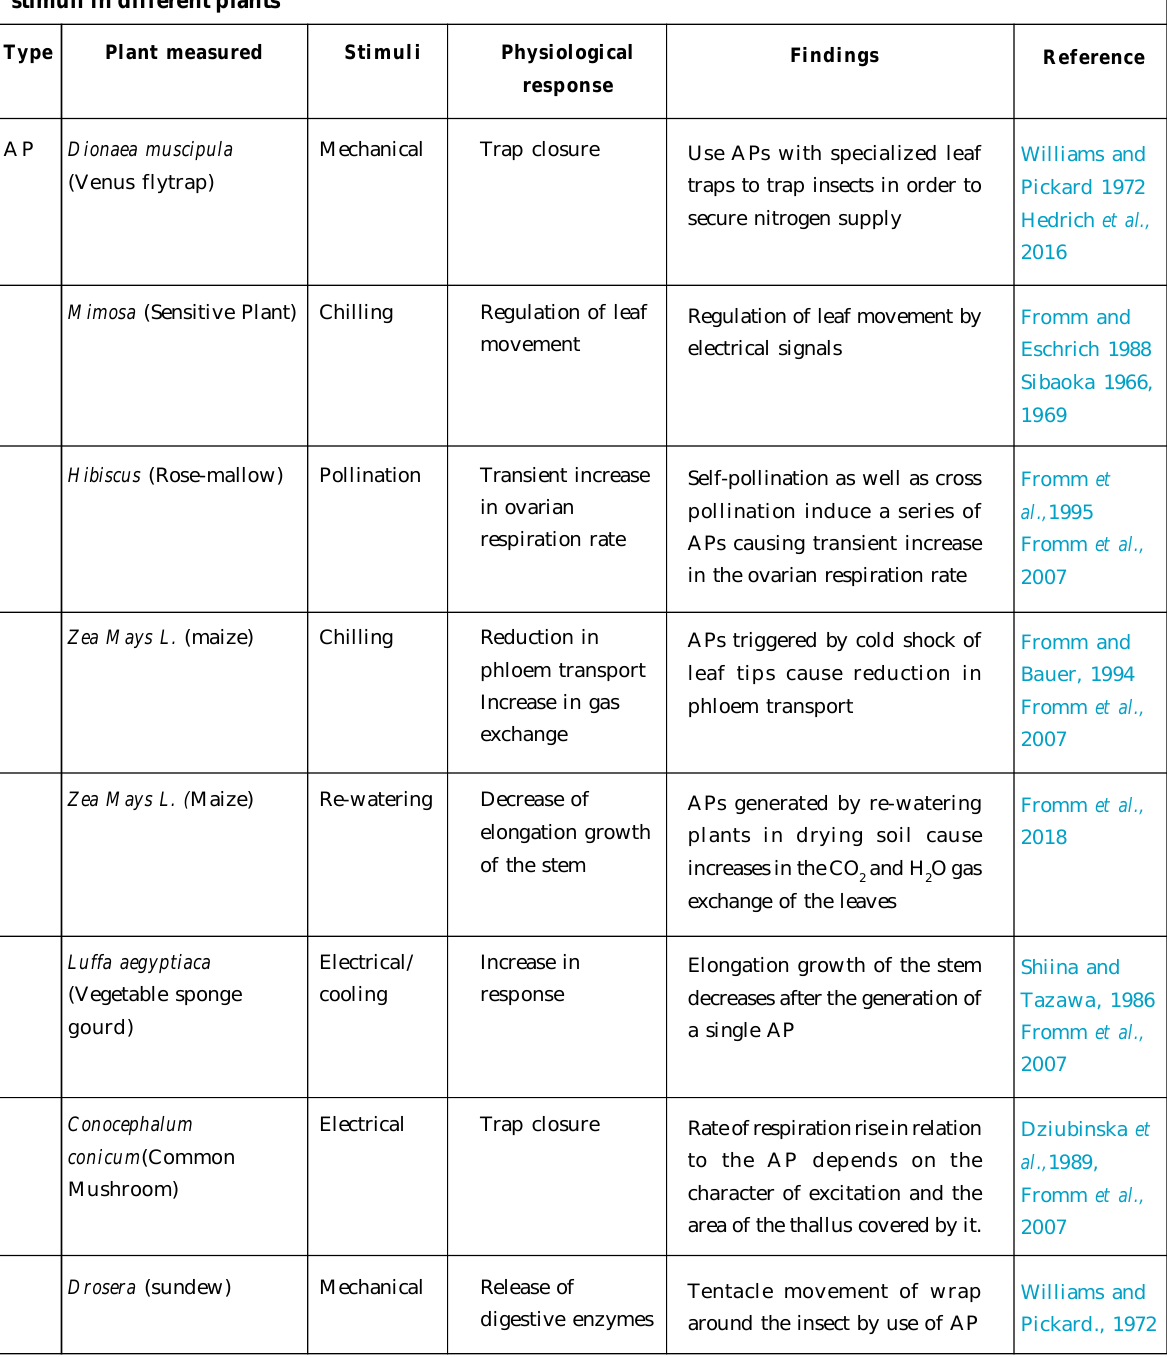
Table 1: Categorization of electric signals. Action and variation potentials as measured under different stimuli in different